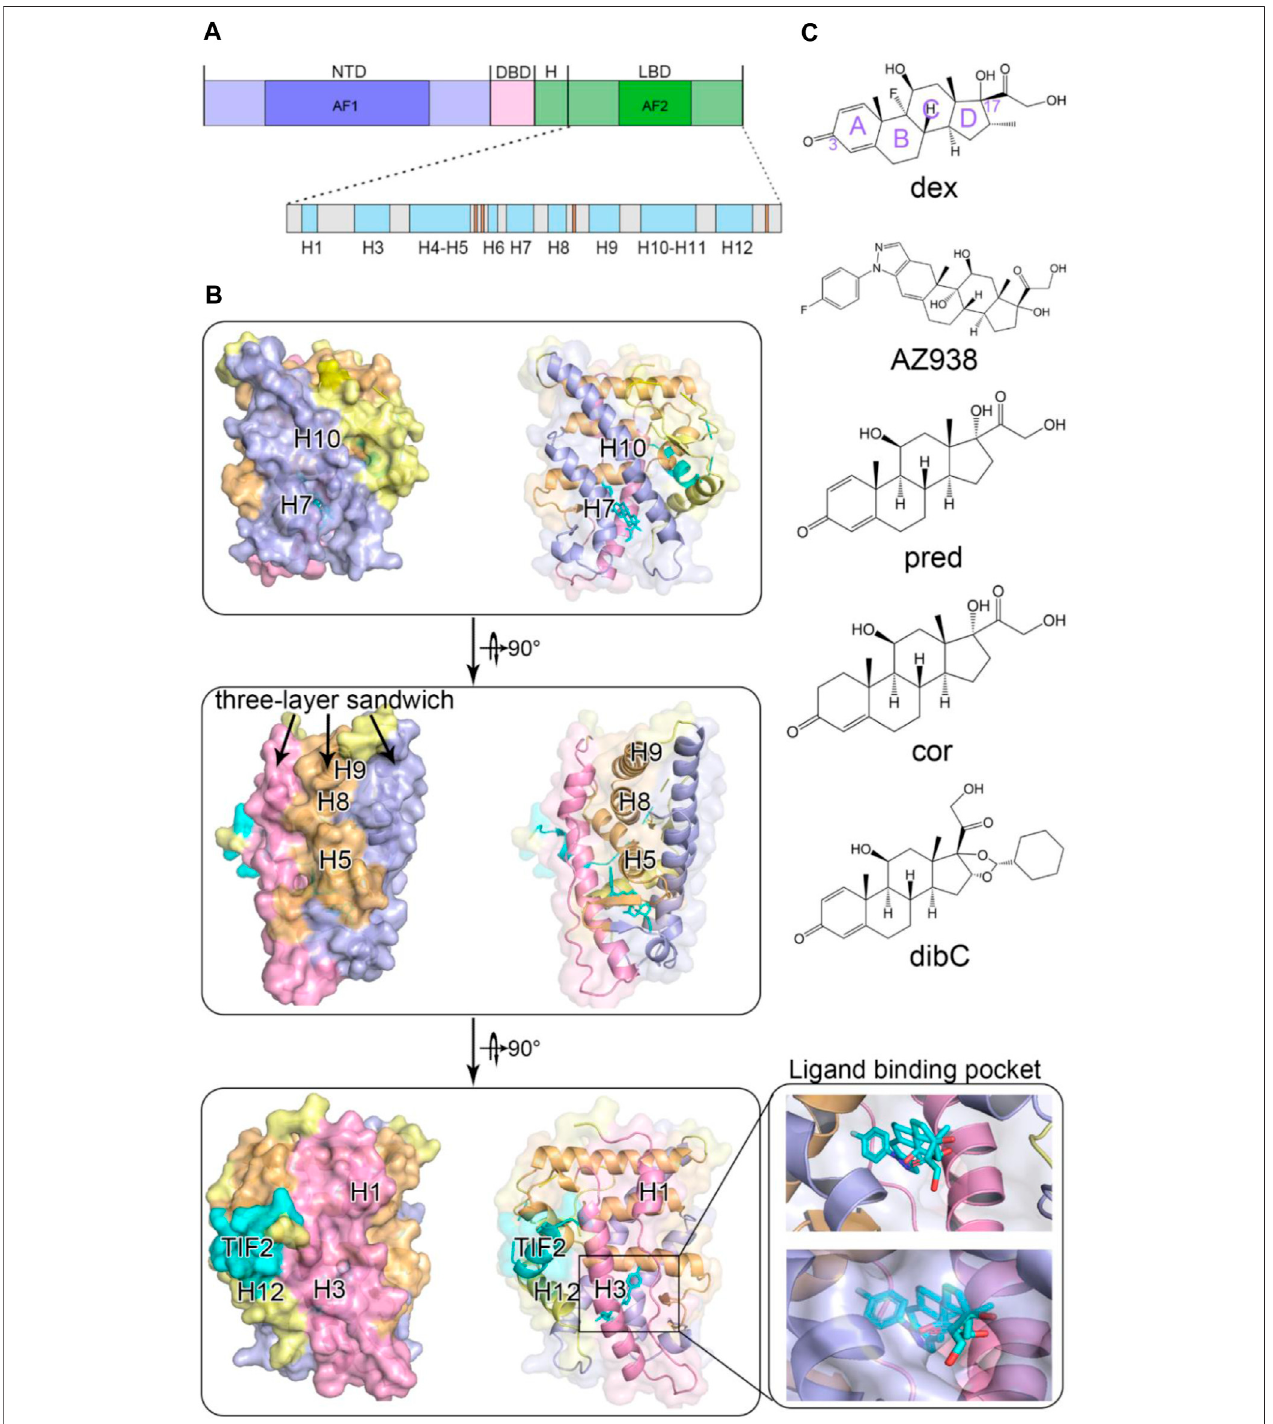
FIGURE 1 | Overall structure of glucocorticoid receptor with agonists and a cofactor. (A) domain organization of GR. (B) cartoon representation of GR ligand- binding domain with helices colored according to the three-layered sandwich structure. (C) chemical structures of fi ve agonists.